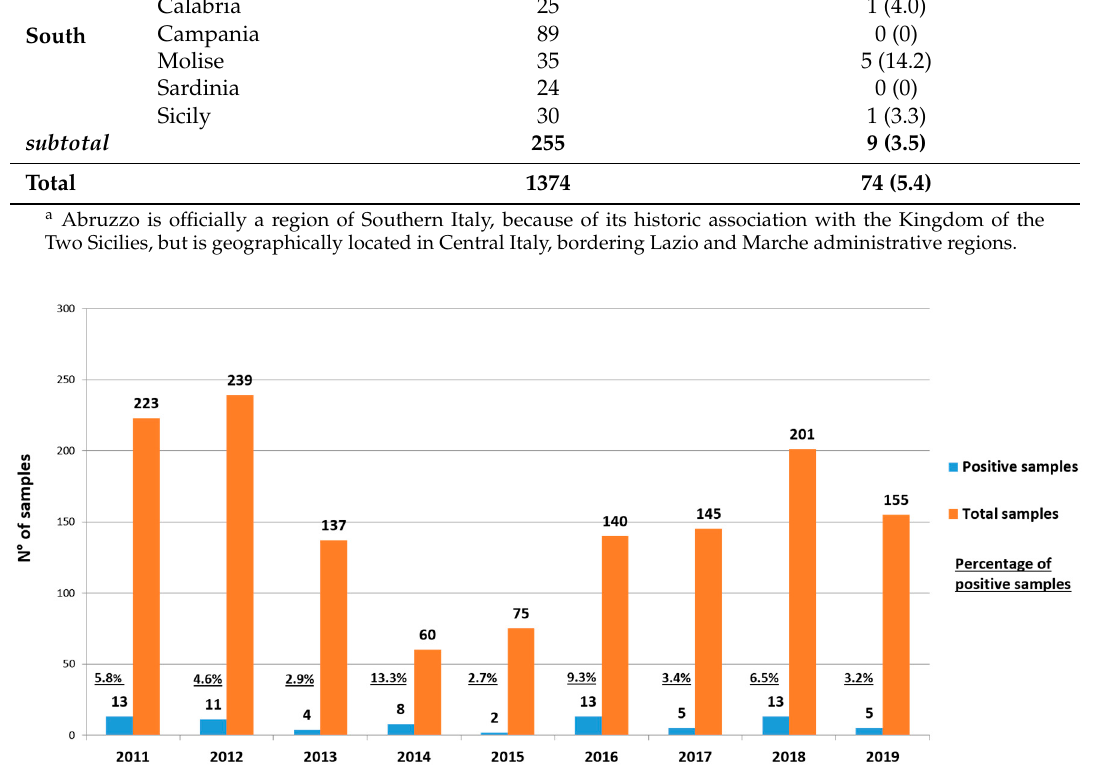
Figure 3. The number of HEV genotype 1 (blue columns) and genotype 3 (orange columns) positive samples detected during the study period (2011–2019). A phylogenetic tree of the Mtase-ORF1 fragment obtained from the HEV strains detected in this study is shown in Figure 4A,B. The tree includes, in addition to the study sequences, clinical, environmental, and animal (swine) sequences previously detected in Italy. According to the sequencing results, the phylogenetic analyses showed that the strains were grouped into two main clusters, related to HEV G1 and G3. HEV G3 strains showed high sequence identity with human sequences detected in autochthonous cases (no travel history) and swine in Italy, and most of the G1 strains showed 100% nt identity with Italian strains detected in patients traveling in endemic areas.